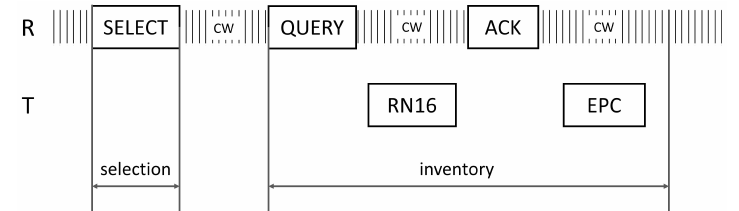
Figure 5. Selection and Inventory stages, in EPC